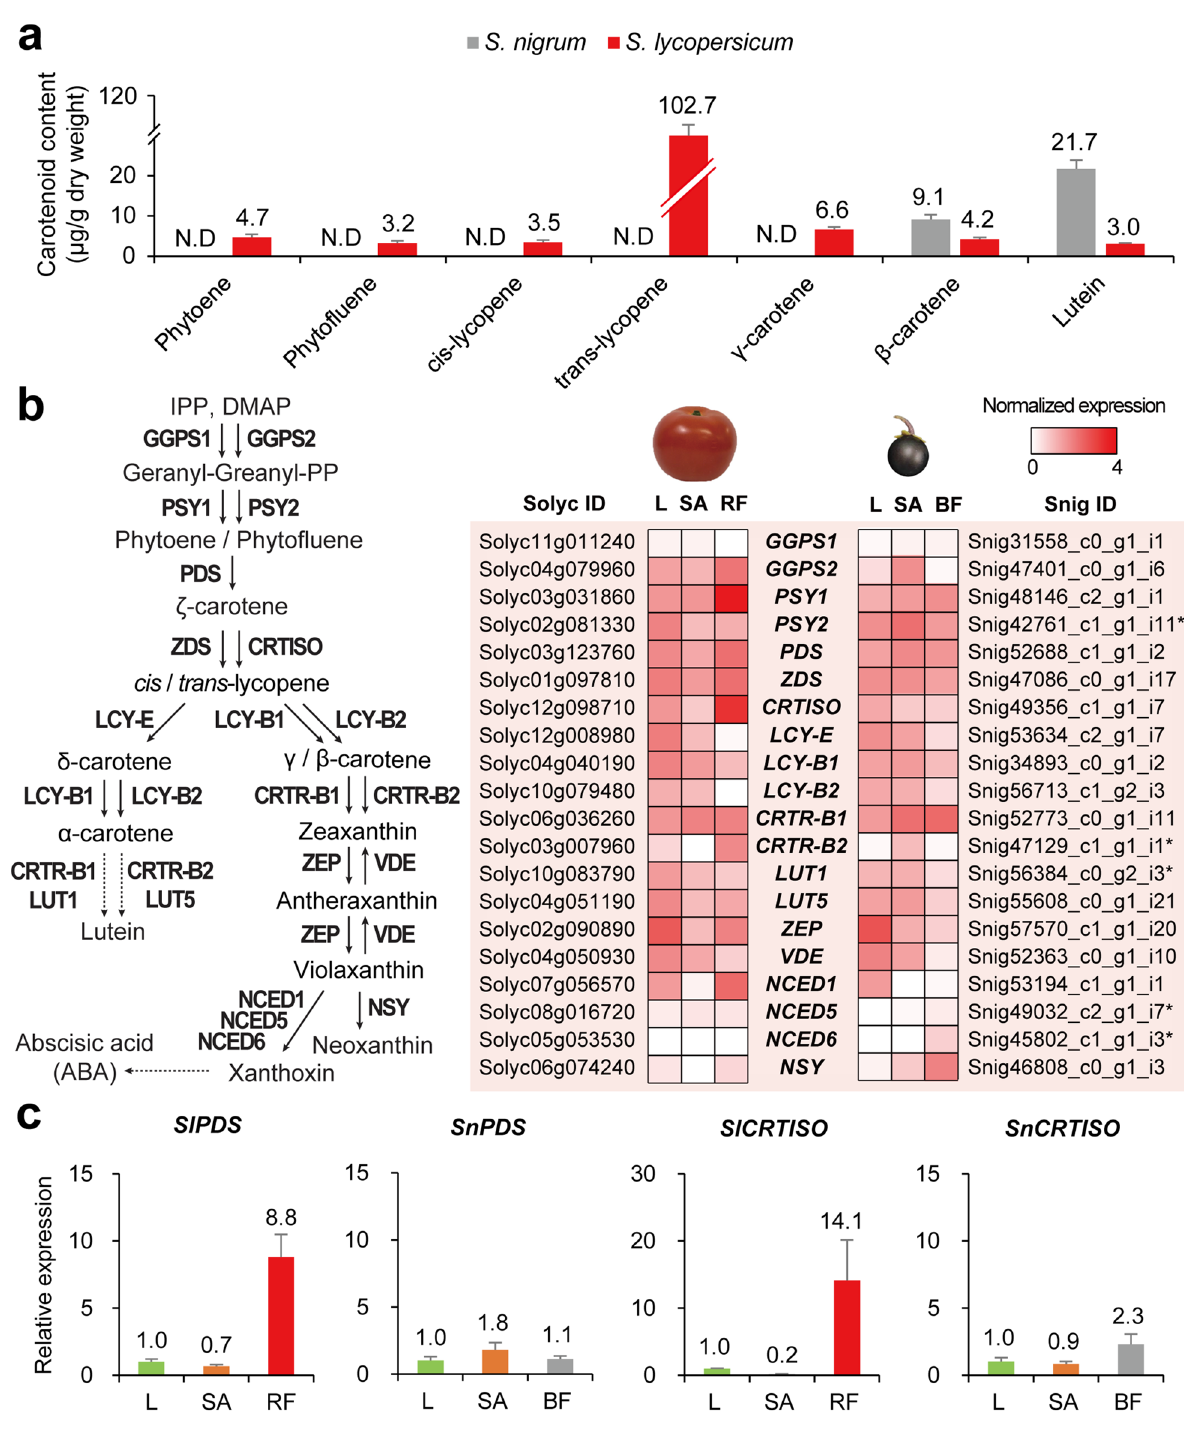
Figure 4. Comparison of metabolites and expression profiles in carotenoid biosynthesis pathway. ( a ) Carotenoid contents in mature fruits of S. nigrum and S. lycopersicum . Data are shown as mean ± standard deviation: n = 5; five technical replicates, a minimum of 50 fruits were pooled. N.D, not detected. ( b ) Carotenoid biosynthesis pathway and expression profiles of carotenoid biosynthetic genes. Dotted arrows indicate the condensed pathway. S. nigrum unigenes with asterisk represent genes with highest homology. The expression is normalized by log 10 (TPM + 1). ( c ) qRT-PCR results for PDS and CRTISO between the two species. Expression levels of each gene were normalized with the value of leaf and UBIQUITIN was used as the endogenous control. Data are shown as mean ± standard deviation: n = 2, pooled samples and two technical replicates. L, leaf; SA, shoot apex; RF, red fruit; BF, black